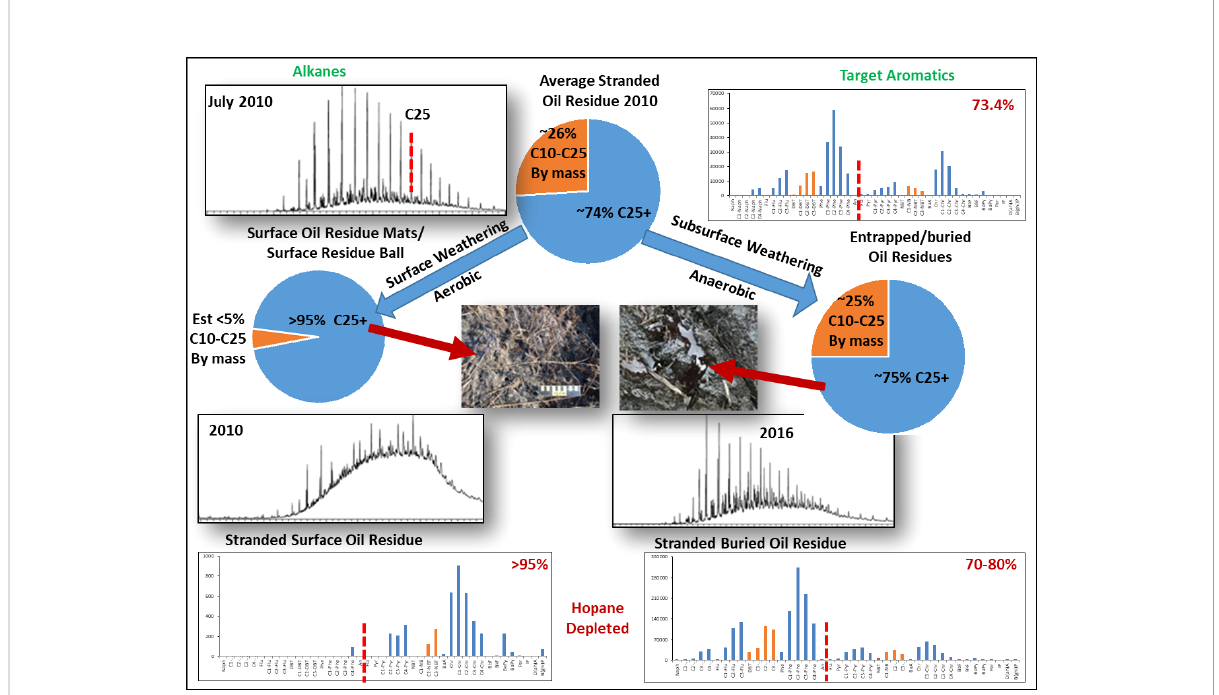
FIGURE 12 Diagram estimating the composition of Deepwater Horizon Oil residues in three fractions as this spilled oil undergoes compositional changes during weathering. These fractions are: C 1 to C 10 , containing hydrocarbons that are low molecular weight compounds and will rapidly be lost to evaporation and or dissolution, this fraction has been depleted in stranded oil residues; C 10 to C 25 , containing moderate molecular weight hydrocarbon and NSO compounds that are susceptible to loss by evaporation, dissolution, microbial weathering and to photo oxidative production to oil soluble and water soluble oxy hydrocarbons products; C 25 +, containing higher molecular weight hydrocarbons and NSO compounds such as the 5-6 ringed PAH compounds and also includes resins, asphaltenes and oil soluble oxy compounds. As the relative composition of C 25 + fraction gets larger, the oil residues become much more viscous, even solid, and are sticky, covering and coating stranded shorelines with an oily material that degrade very slowly. The oil residue shown on the right is from oil entrapped below a surface tarmats in an anaerobic zone, undergoing very slow anaerobic degradation, and still being liquid oil in 2016. The residue on the left is from a surface tarmat that had been heavily weathered, with little C 10 to C 25 fraction remaining in 2010. The top pro fi le data show the typical chemical composition of weathered liquid oil that came ashore in